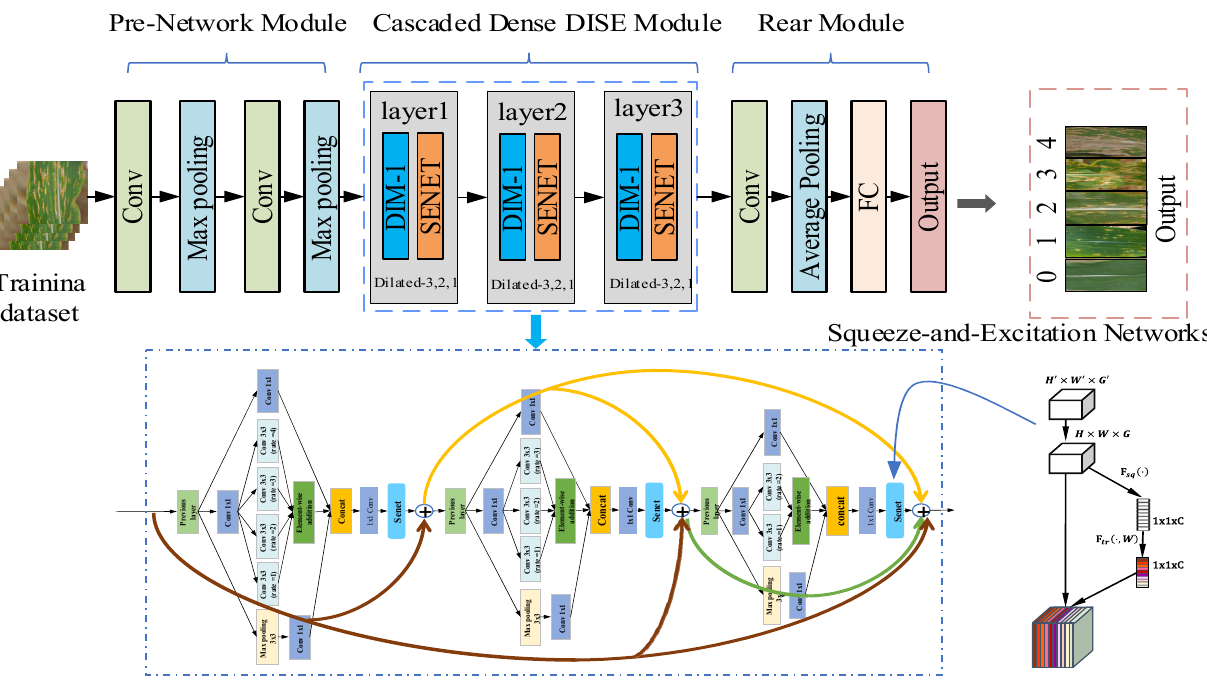
Figure 4. Neural network structure for grading detection of maize small leaf spot. Table 3. Main parameters of DISE-Net model.